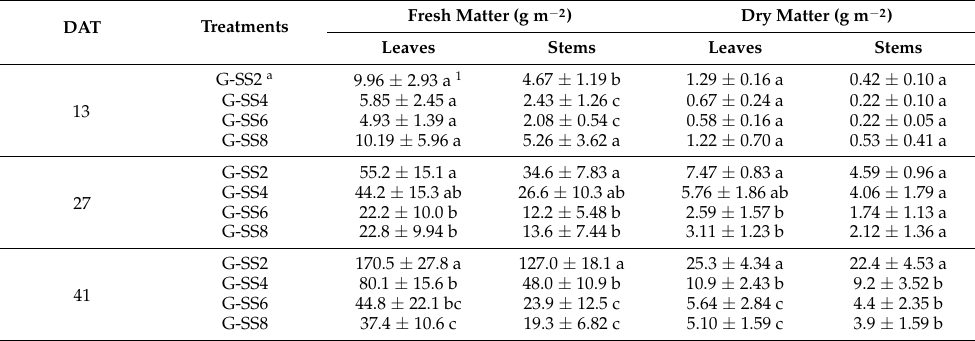
Table 3. Mean fresh and dry matter (g) ( ± SE) of leaves and stems of basil plants irrigated by means of the G-SS during the first experimental period.